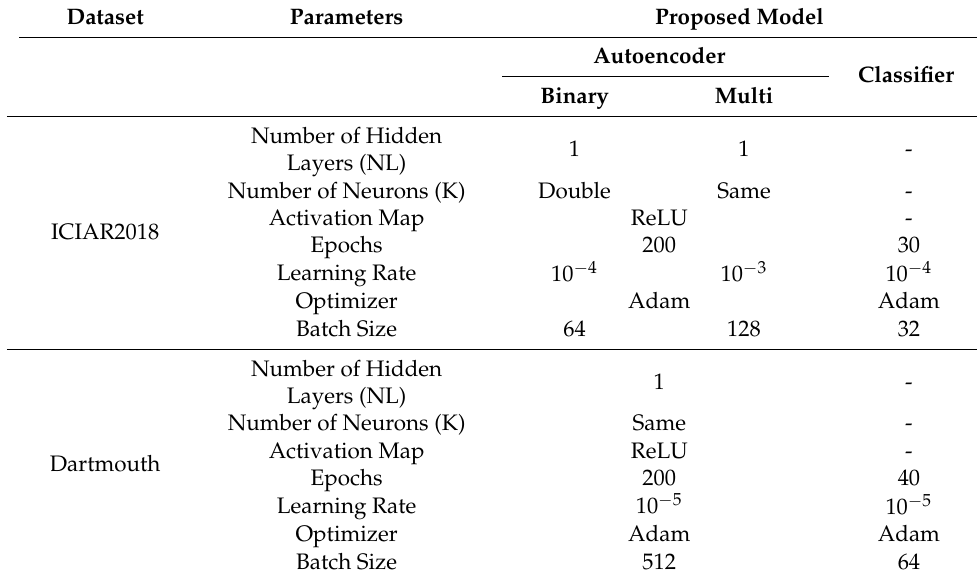
Table 4. The best hyperparameters of our